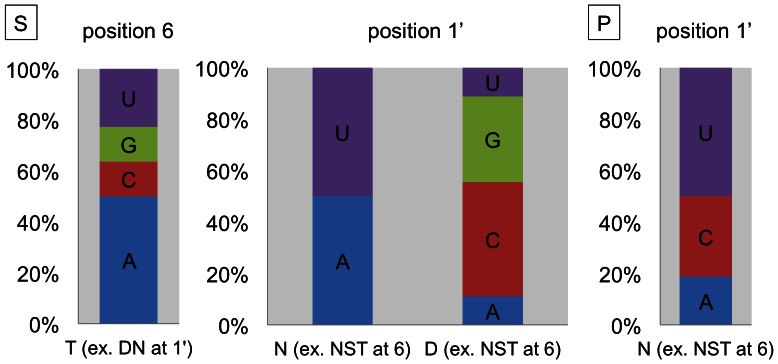
Positions 6 or 1′ in P and S motifs in RNA editing PPRs correlate with specific nucleotides.Depicted are individual connections of positions 6 or 1′ in those instances, where the most prominent combinatory amino acid identity correlations between positions 6 and 1′ are excluded as indicated (ex.). In these instances single amino acid positions correlate with distinct nucleotide preferences in S and P elements, respectively. For the S elements non-random distributions are found at positions 6 and 1′, for the P elements only at position 1′. The most prominent combinatory amino acid – nucleotide identity correlations which are excluded here have been identified previously (8–10).